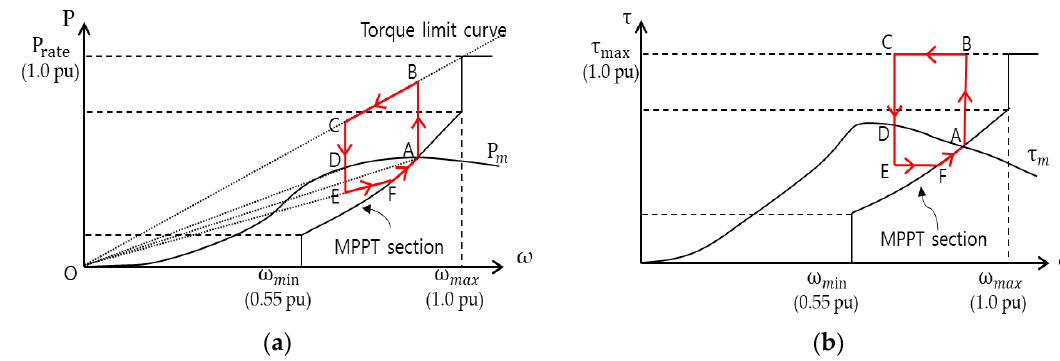
Figure 4. Proposed control operation on the MPPT curve: ( a ) power–rotor speed curve; ( b ) torque–rotor speed curve.